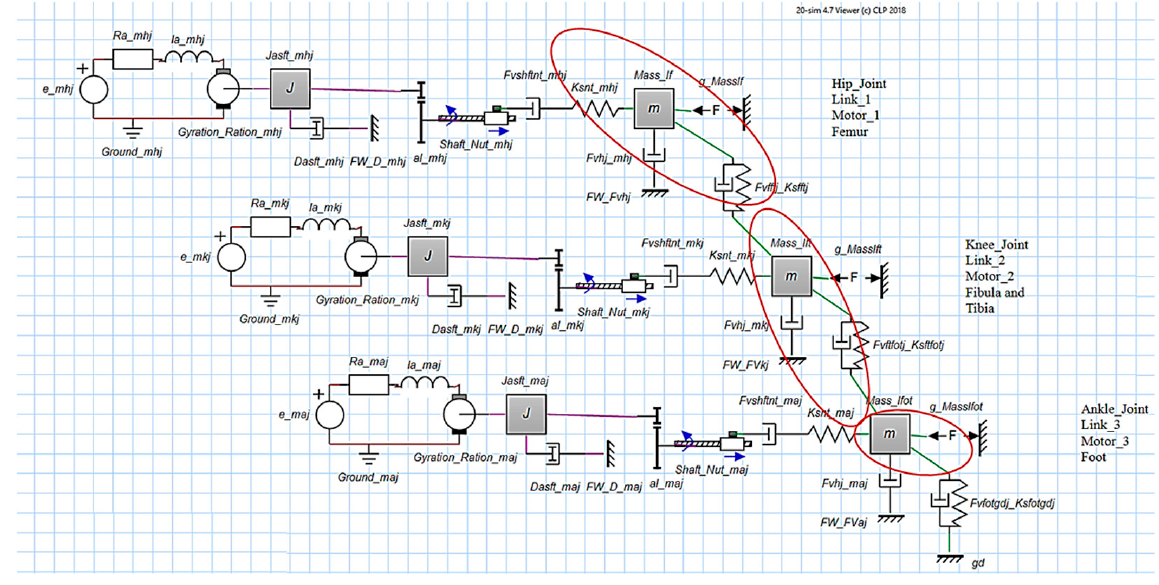
Figure 2. Schematic diagram of lower limb rehabilitation exoskeleton.